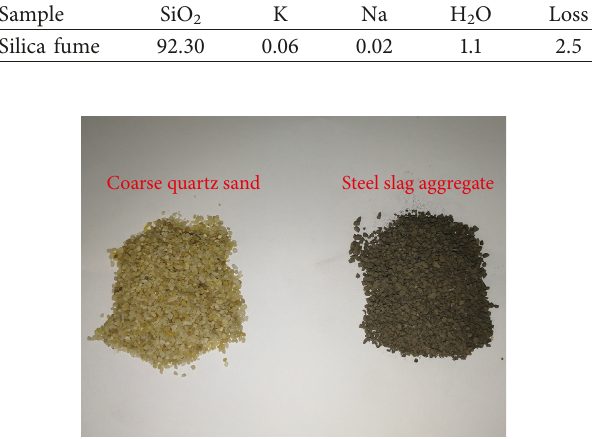
Figure 3: Photo of steel slag aggregate and coarse quartz